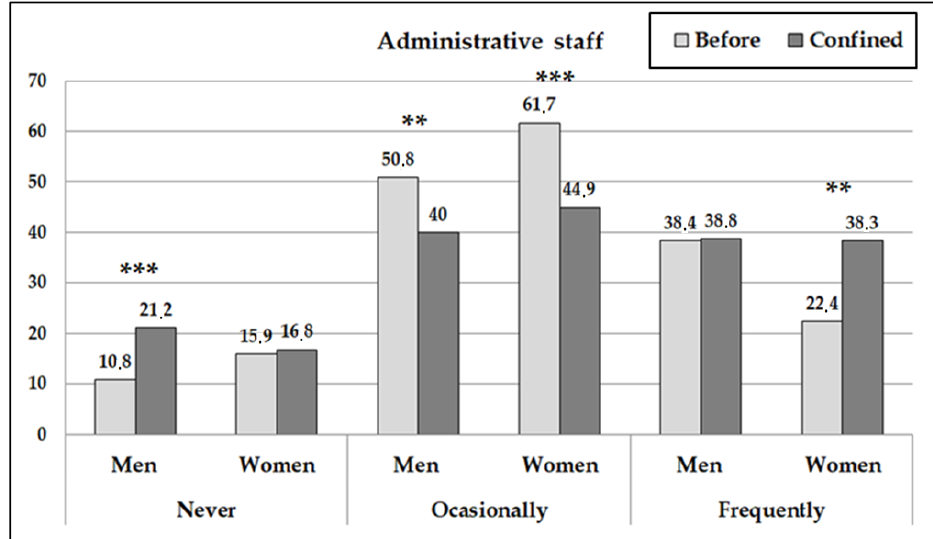
Figure 1. Percentages of administrative workers who carried out physical activity according to frequency before and after the confinement. (The asterisks indicate the significant differences before and during confinement by sex subgroup: ** p < 0.01; *** p < 0.001).